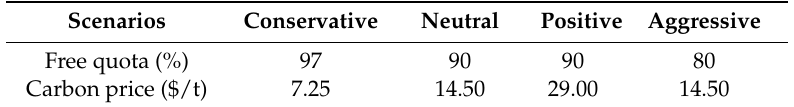
Table 8. Different scenario settings.